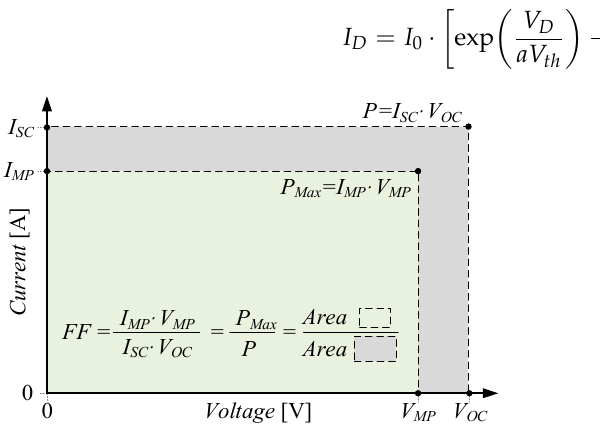
Figure 1. I–V property curve of a general PV panel.